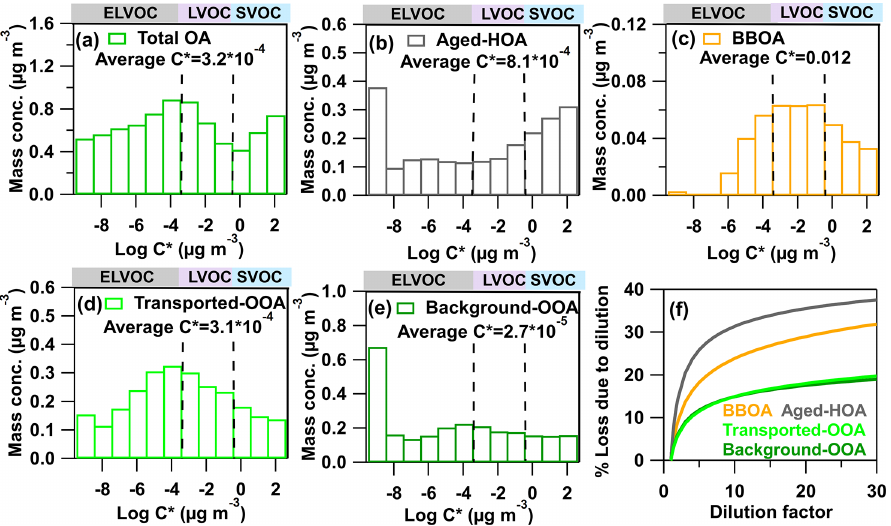
Figure 8. Volatility distributions of (a) total OA, (b) aged-HOA, (c) BBOA, (d) transported-OOA, (e) background-OOA. The unit of average C ∗ is µgm − 3 . (f) The additional mass losses ( E loss ) of four OA factors as functions of the dilution